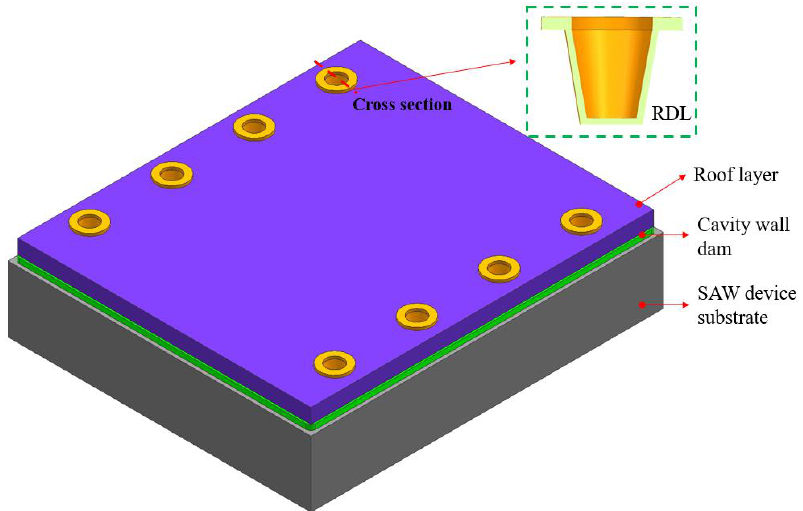
Figure 6. The single-die FE modeling. Table 1. Material properties of the two single-die models. Items CTE